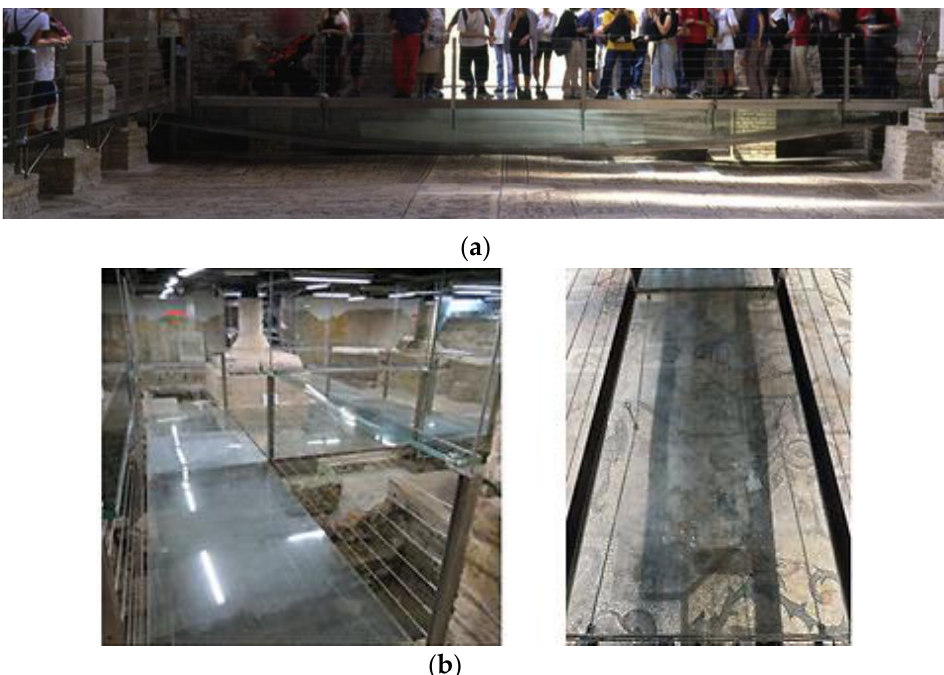
Figure 2. Examples of glass pedestrian systems (( a ) reproduced from [16] with permission from Elsevier©, copyright license number agreement 5502960982555, March 2023; ( b ) reproduced from